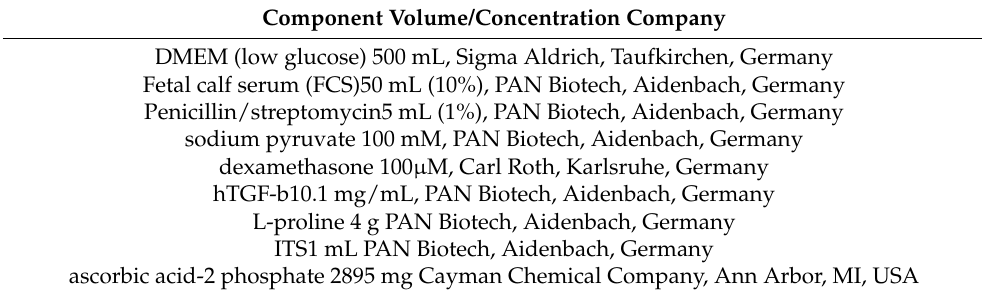
Table 1. Chondrogenic differentiation medium. Component Volume/Concentration